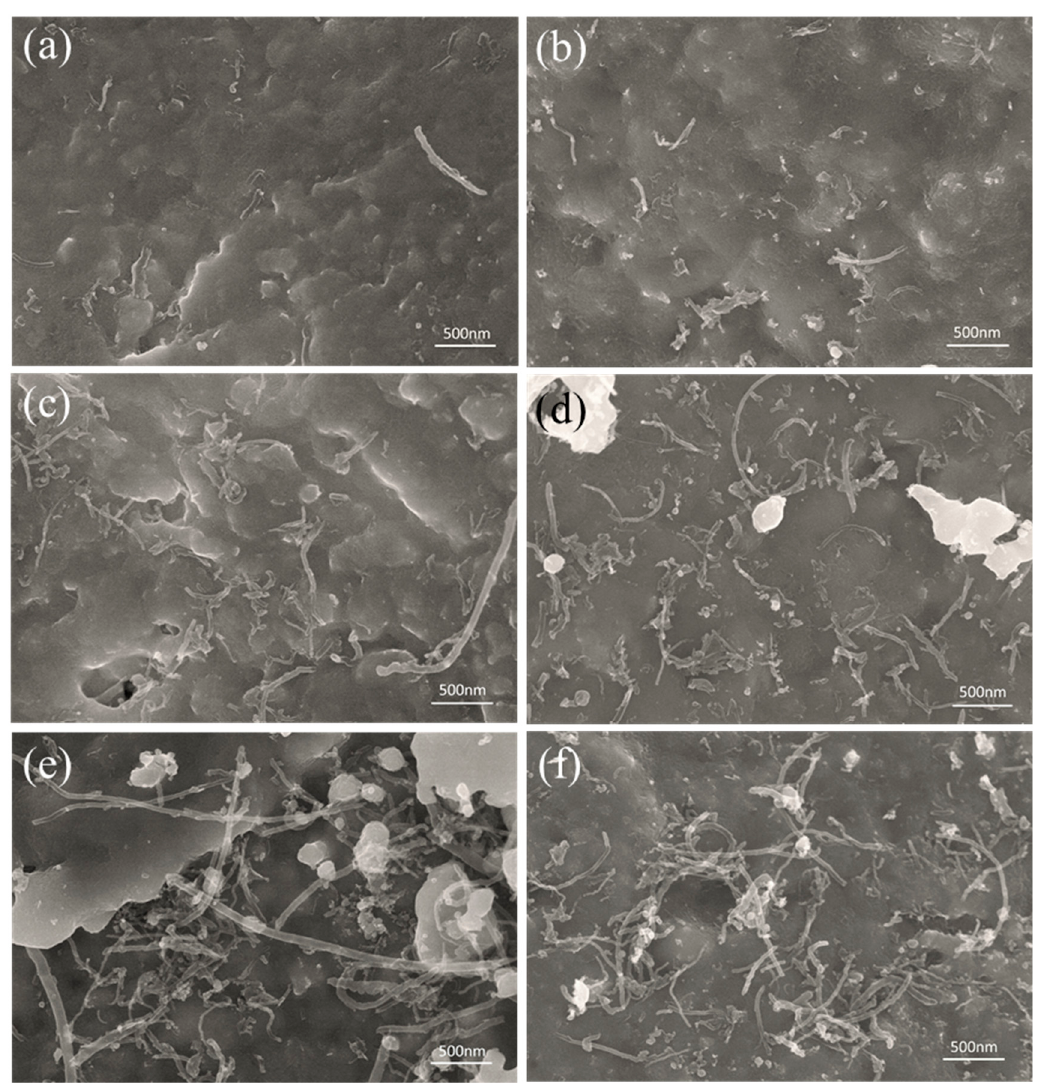
Figure 5. ( a , c , e ) SEM images of the 0.1 wt %, 0.3 wt %, and 0.5 wt % CNT-Cu composite powder, respectively; ( b , d , f ) SEM images of the SP-0.1 wt %, SP-0.3 wt %, and SP-0.5 wt % CNT-Cu composite powder, respectively.